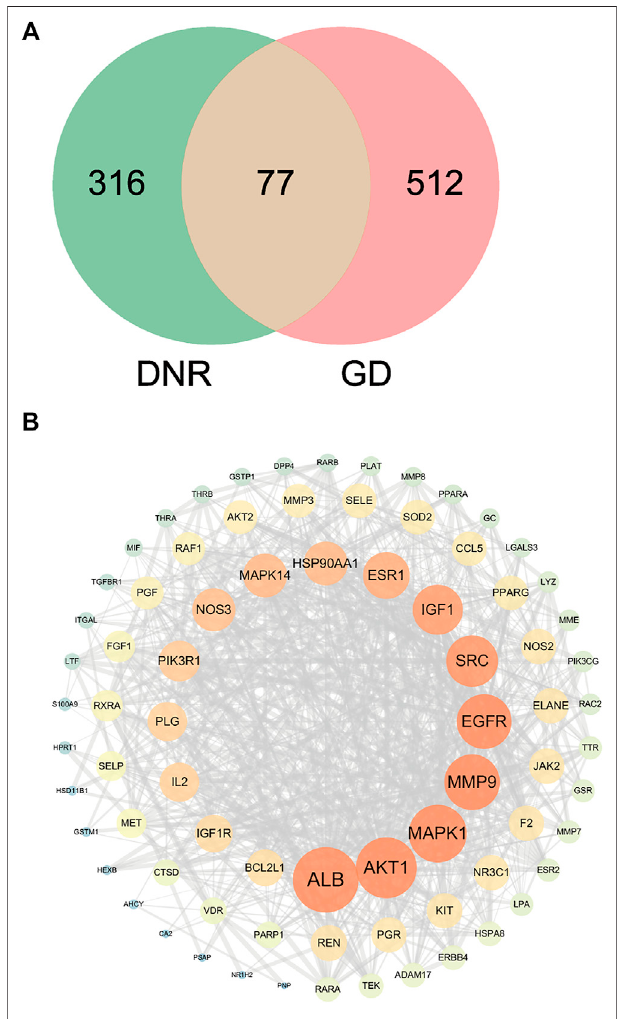
FIGURE 4 | Venn diagram and PPI network for overlapped targets. (A) Venn diagram of overlapping genes of DNR and GD. (B) PPI network of GD ’